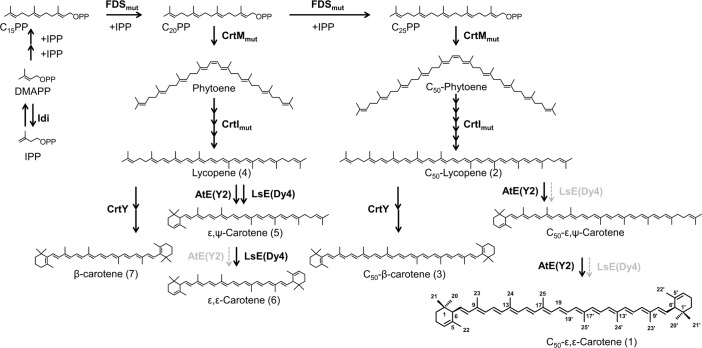
Pathways for C50-ε-cyclic–carotenoids.